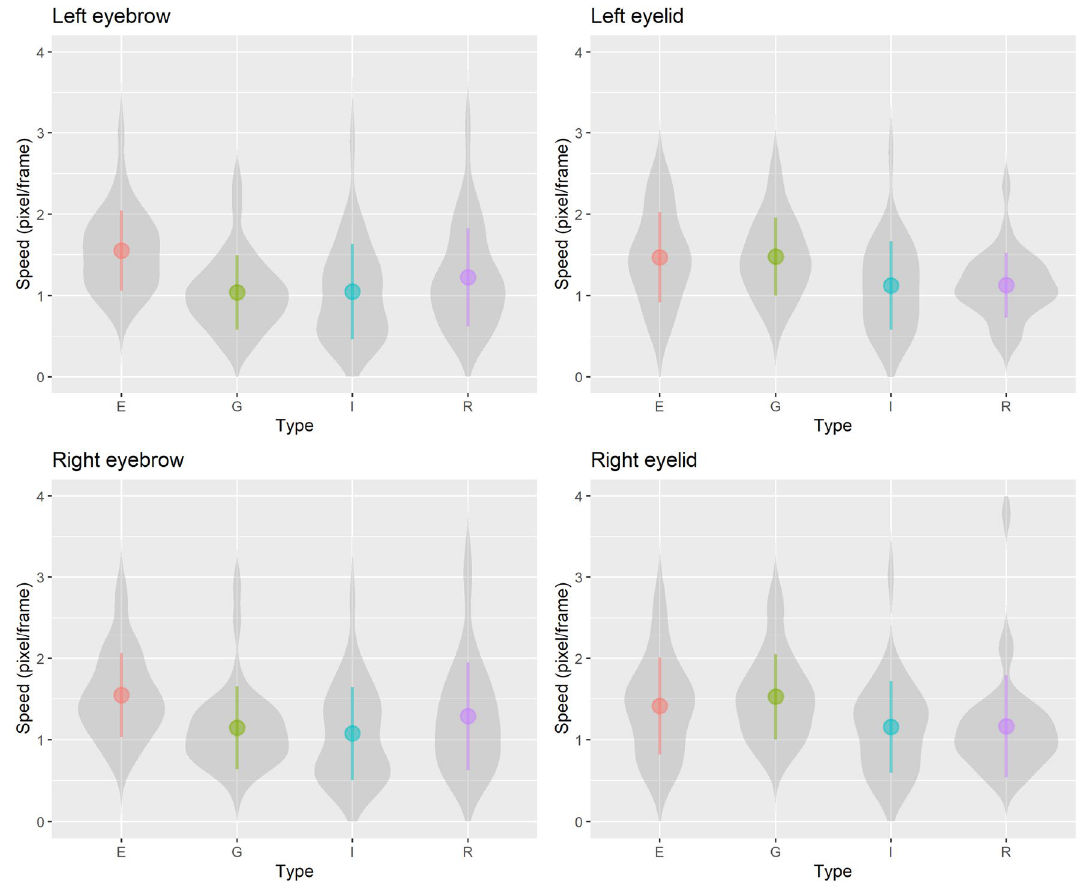
Figure 4. The speed (pixel/frame) of the vertical movement for both eyebrow and eyelid. Violin plots show the Kernel probability density of the data. Each point indicates the mean and the bars show 1 standard deviation